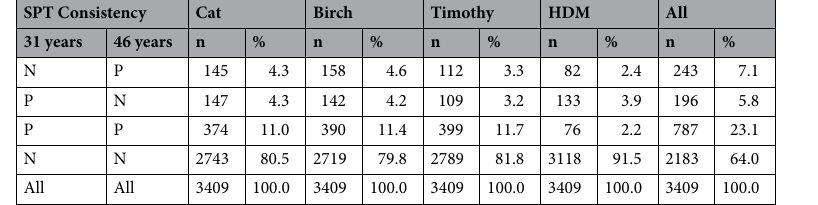
SPT Consistency